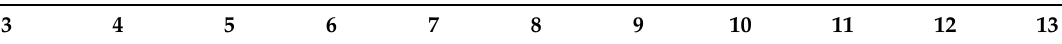
Table 5. Pearson correlations between the different dependent variables with